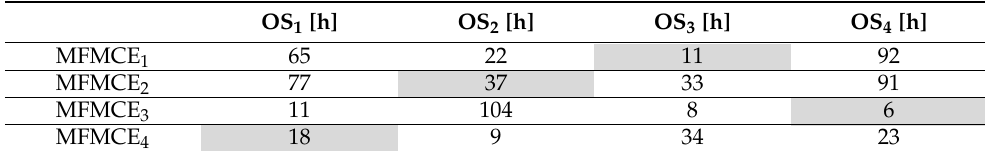
Table 9. Minimum lead-total time of the operation